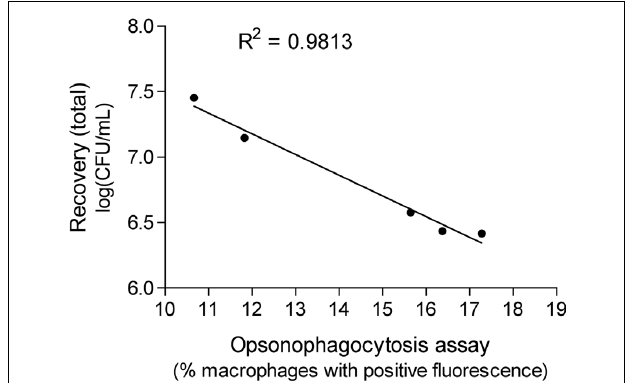
FIGURE 7 |The correlation between average total bacterial recovery after mucosal immunization and the enhancement of phagocytosis of M. catarrhalis due to opsonization by antibody raised against the same antigen.